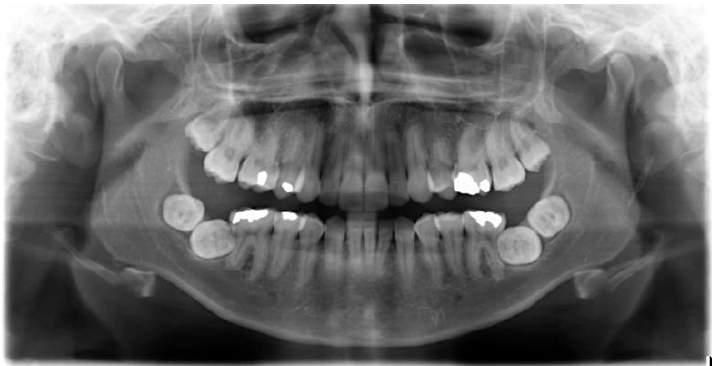
Figure 2. OPT of patient aged 18 years.